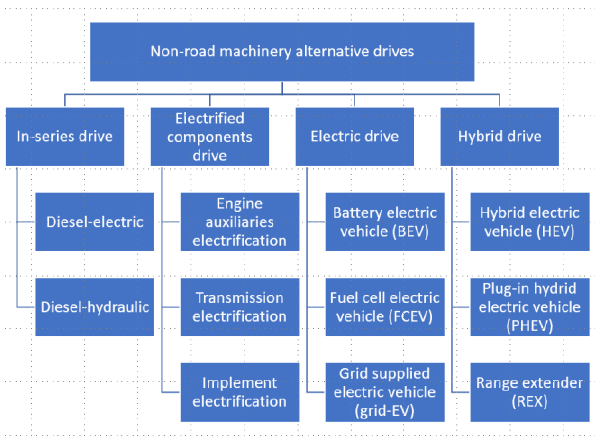
Fig. 2. Non-road machinery alternative drive